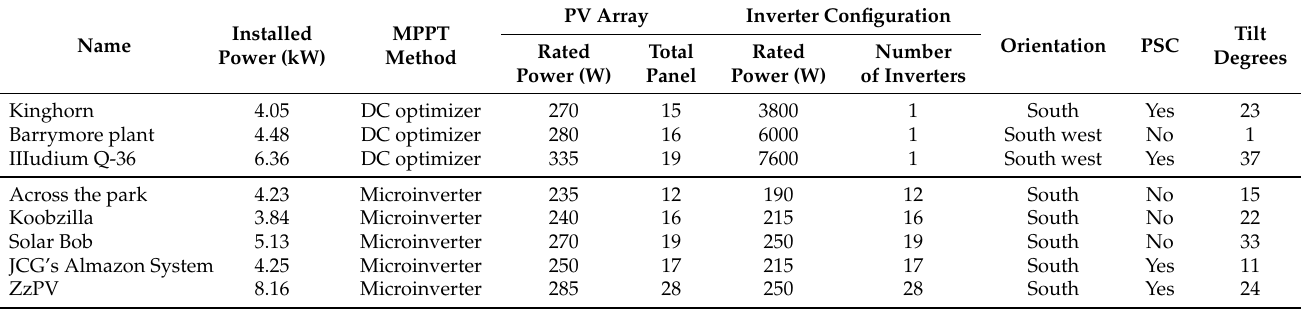
Table 2. PV stations located in Kinghorn, San Diego, CA, USA (postcode: 92129) used in study of the annual energy yield. The chosen stations share the same postcode (within 4 km). Thus, they are assumed to suffer similar weather condition. PSC decrease temporarily the amount of radiation reaching the solar